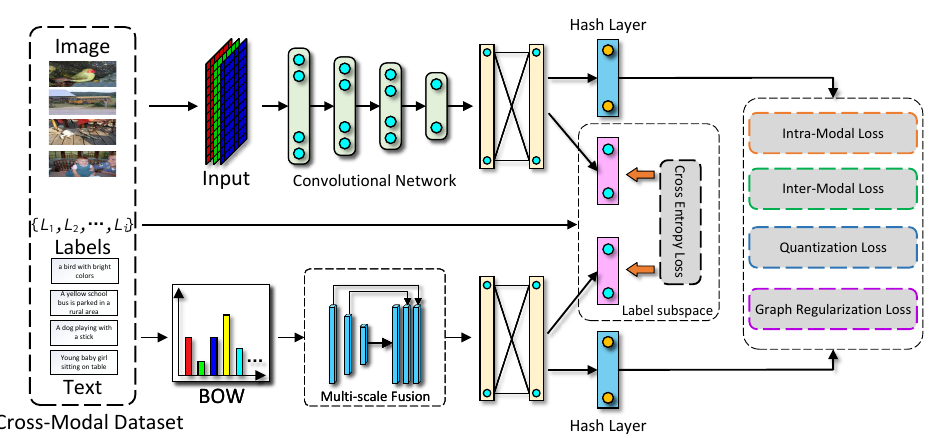
Figure 1. The framework of DMSFH. It contains three main components: (1) the feature learning module, which contains a classical convolutional neural network for image-modality feature learning, and a multi-scale fusion-based convolutional neural network for text-modality feature learning; (2) a multi-label semantic information learning module that is realized by deep neural networks, which is to fuse rich semantic information from multiple labels to generate consistent semantic representations in label subspace; (3) a hash function module that is trained by inter-modal and intra-modal pairwise loss, quantization loss, and graph regularization loss to generate cross-modal hash codes.